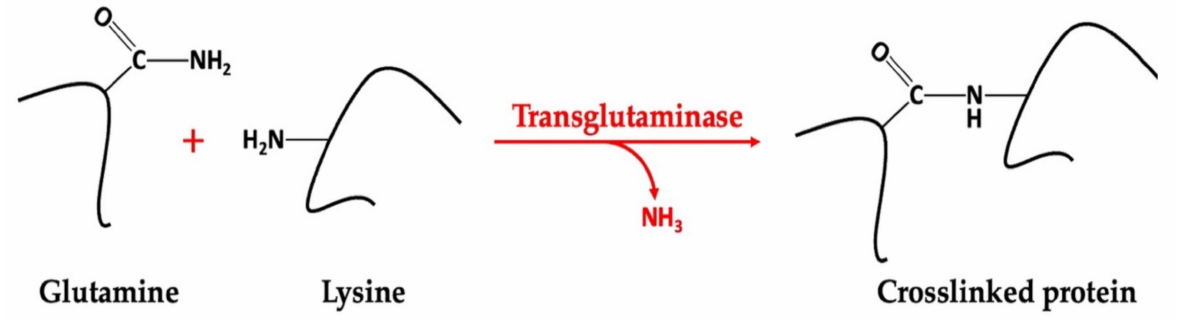
Figure 4. Schematic representation of protein crosslinking mechanism induced by transglutami- nase [125,126].